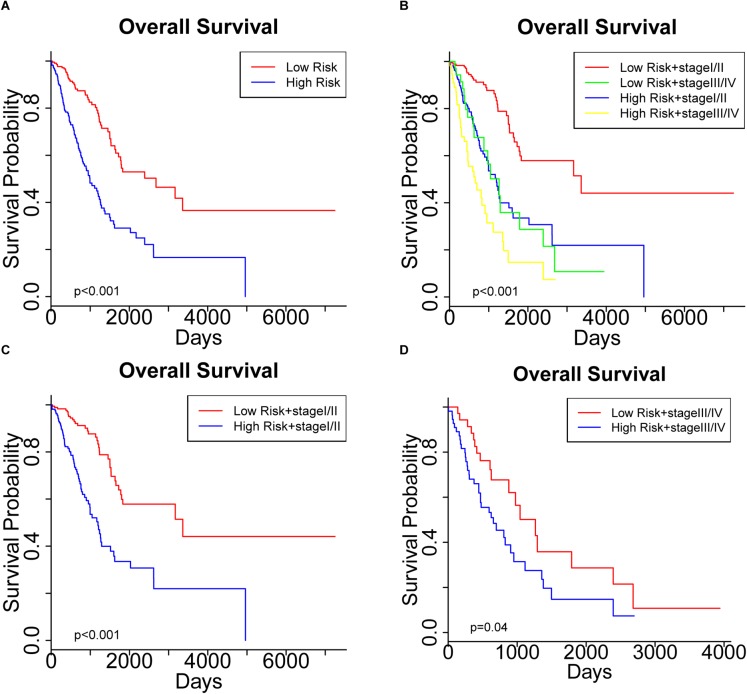
Kaplan Meier curve showing the overall survival (OS) of the patient cohort grouped by (A) prognostic score (PS), and (B) PS plus pathological stage. OS of patients stratified by PS in subgroups with (C) early-stage tumors and (D) advanced- stage tumors.